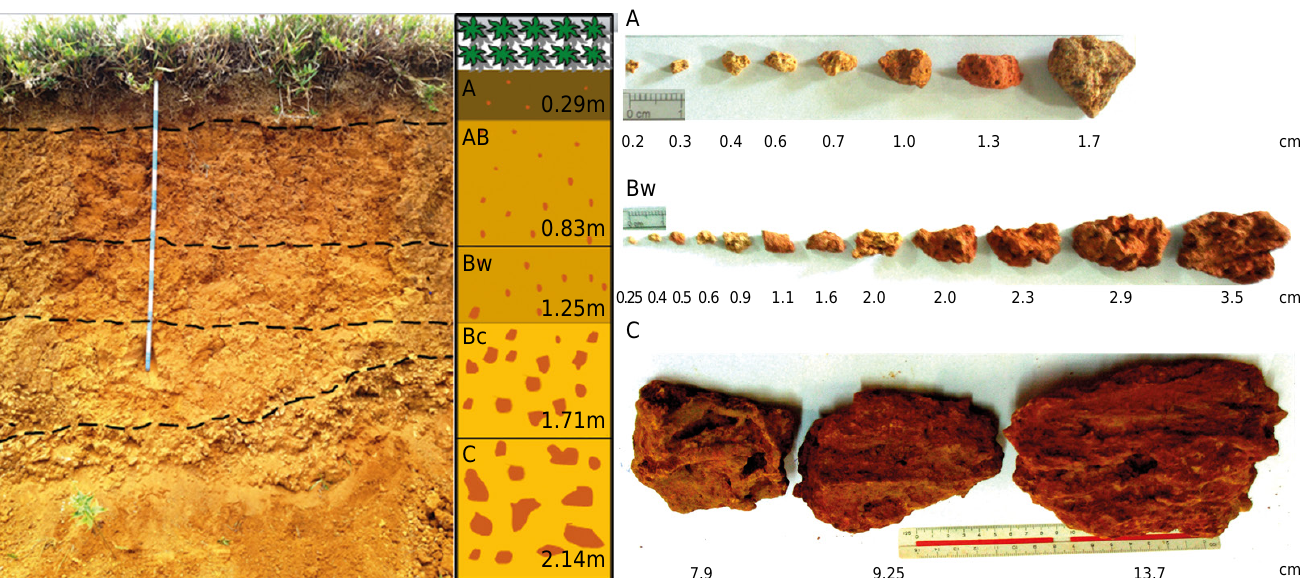
Figure 2. The L3 profile with pedological horizons A, AB, Bw, BC, and C delimited. Bauxite fragments with variable size are visible to the